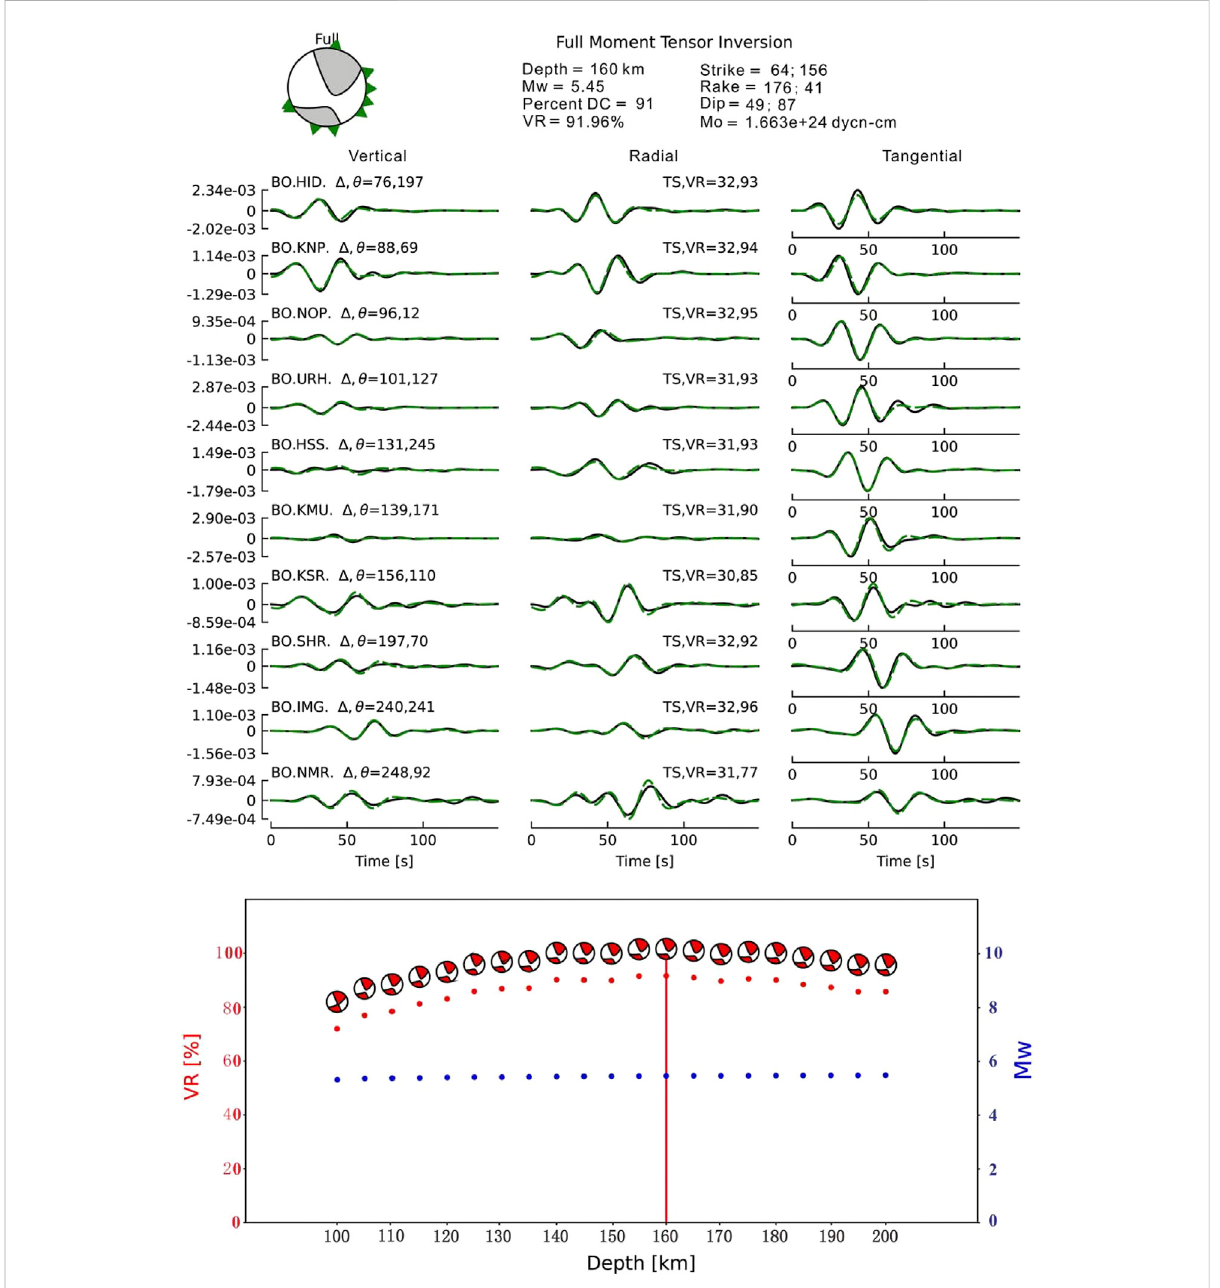
AreversefaultingeventinthePro fi leA-A ’ .ThelocationofthiseventisindicatedbyaredstarinFigure1B.Toppanelshowsthebestsolutionand waveform fi ts (the black observed and green synthetic waveforms) at selected stations. Green triangles around the beach ball indicate station azimuth, and the numbers below the radial and vertical component seismograms are, from left to right: distance, azimuth, time shift in samples, and station-speci fi c VR. Bottom panel shows the solution, in terms of waveform fi ts (variance reduction; VR) and Mw, with respect to FMS depth.